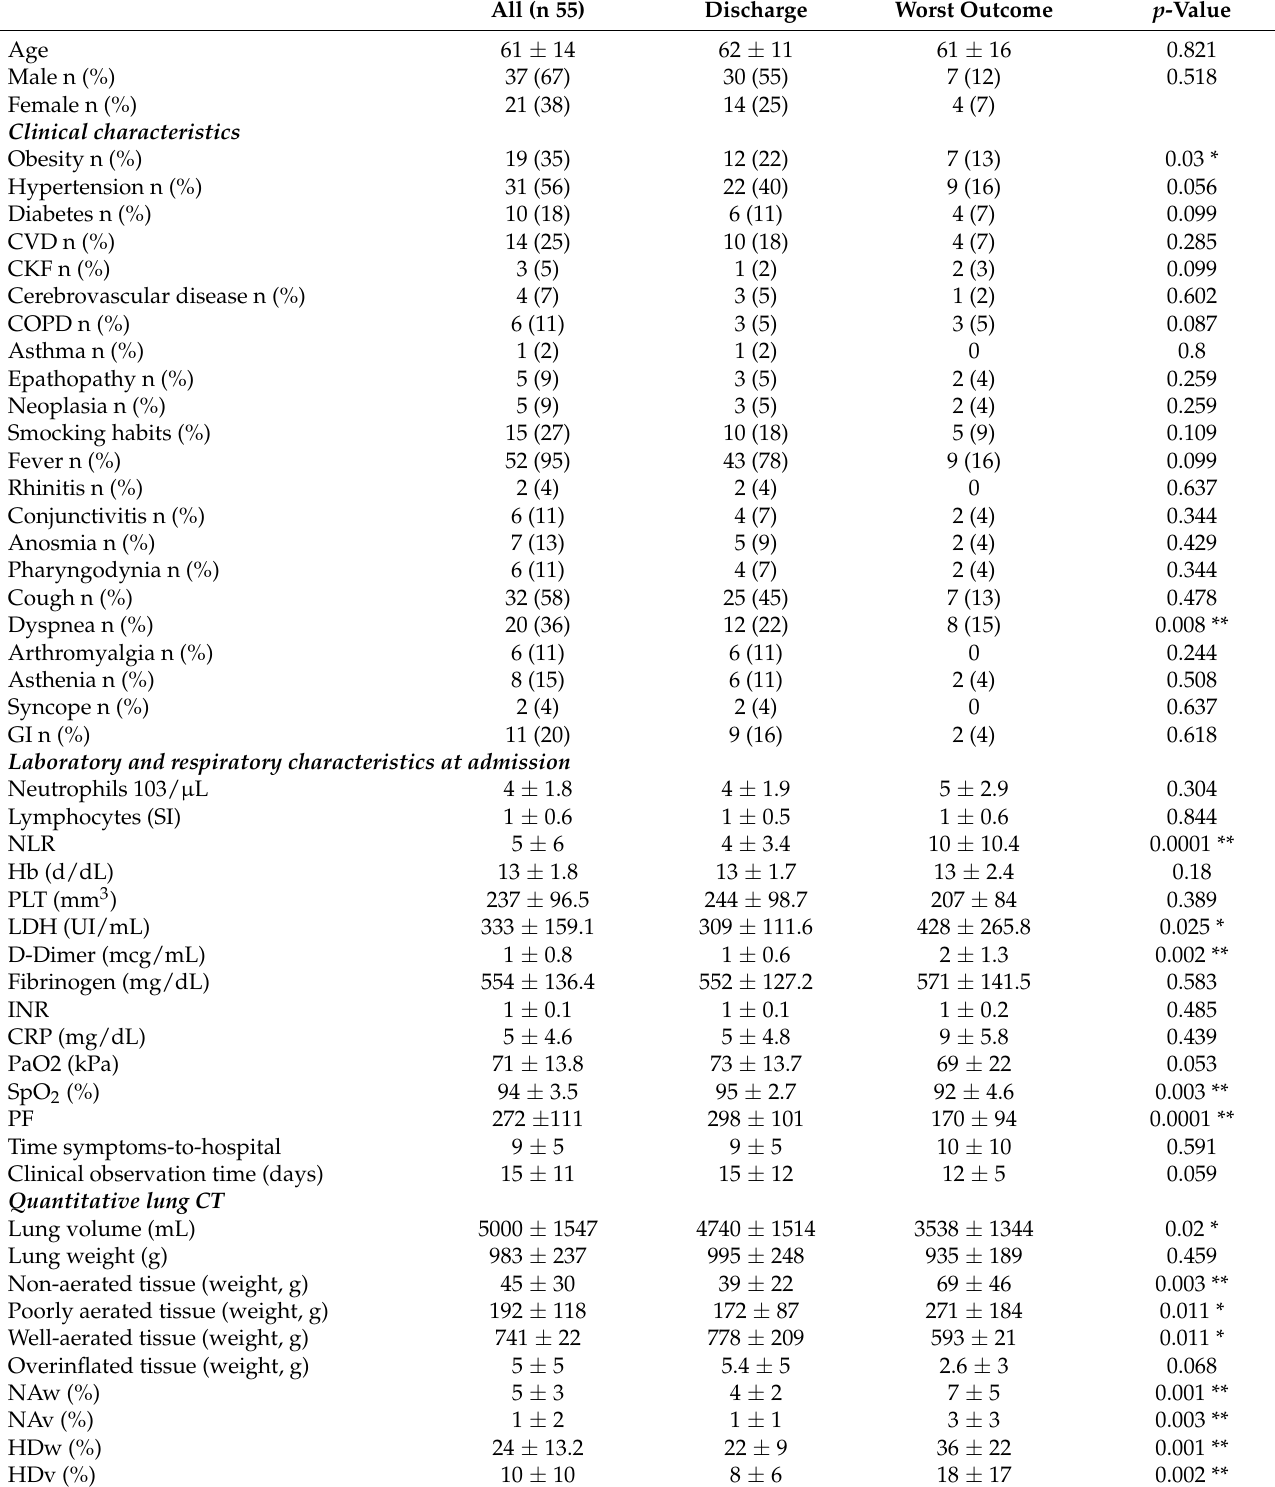
Table 1. Baseline characteristic of patient